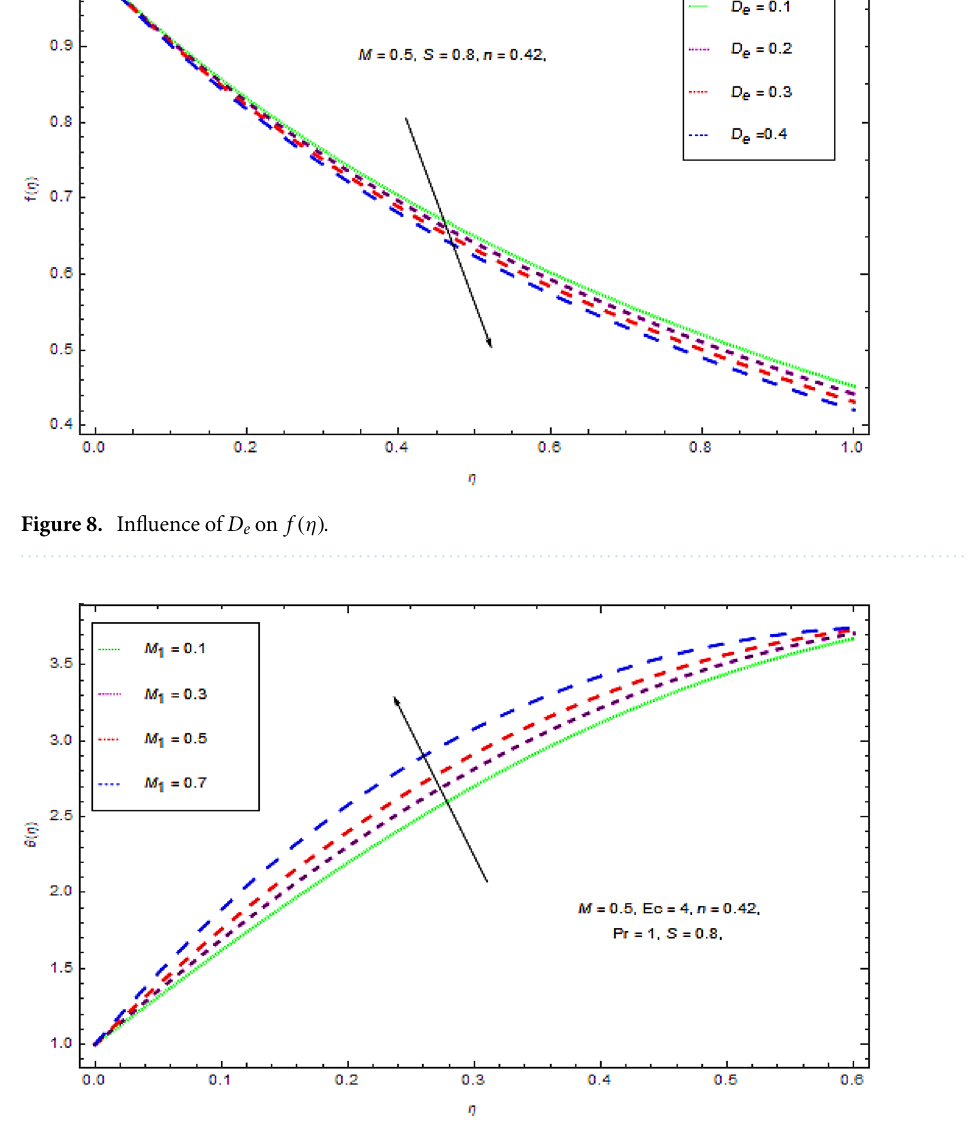
Figure 9. Effect of M 1 on θ(η)